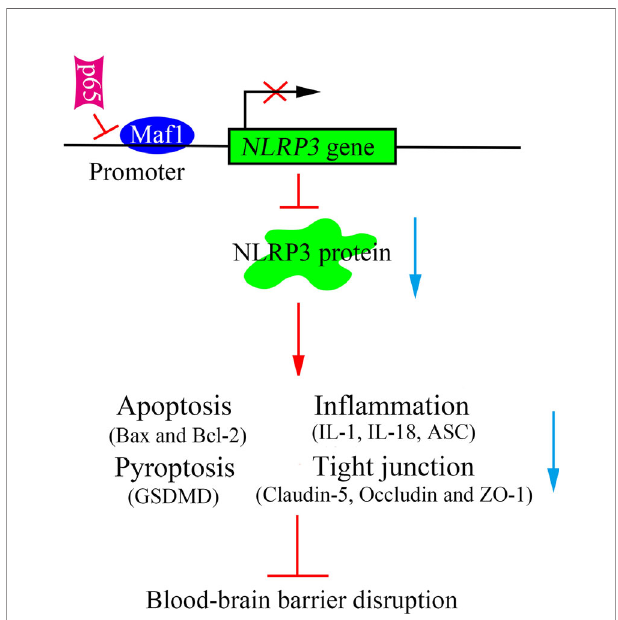
FIGURE 7 | Schematic diagram of the proposed molecular mechanisms. A schematic diagram depicting the molecular mechanism by which Maf1 inhibits blood – brain barrier disruption by competing with p65 to regulate NLRP3 expression. Maf1 protects the blood – brain barrier by directly targeting NLRP3 to decrease apoptosis, the secretion of pro-in fl ammatory cytokines, blood – brain barrier permeability, and nerve